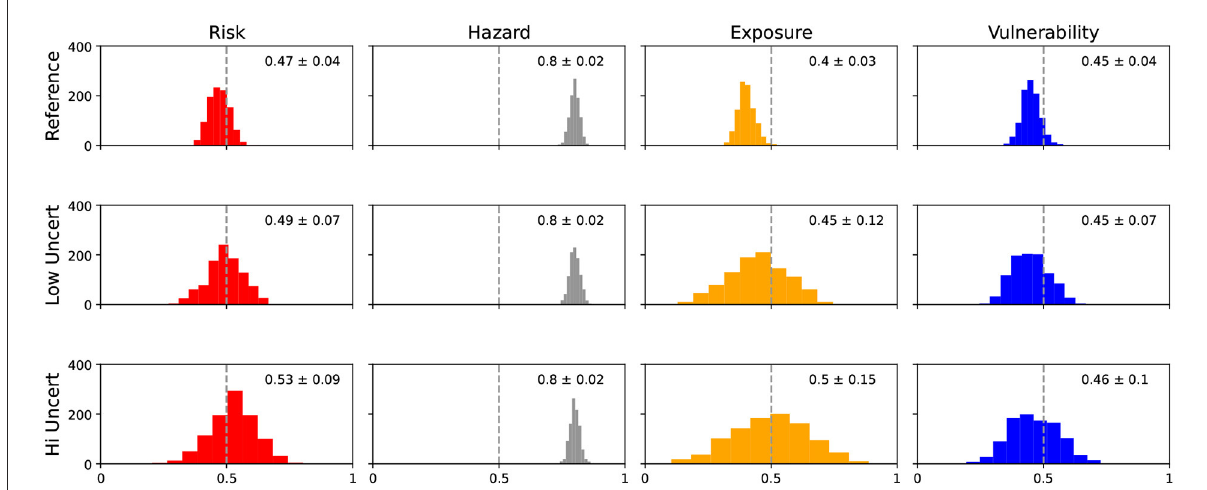
FIGURE7 Sensitivity of the final risk under future scenario SSP585 to different level of incomplete knowledge of the indictors defined in the Impact Chain. The “reference” case (top) illustrates the case when values are assigned to all the indicators for the three components. In the “low uncertainty” case (middle) 4 out of 14 indicators have been considered as unknown, whereas the “high uncertainty” case (bottom) 8 out of 14 indicators have been considered as